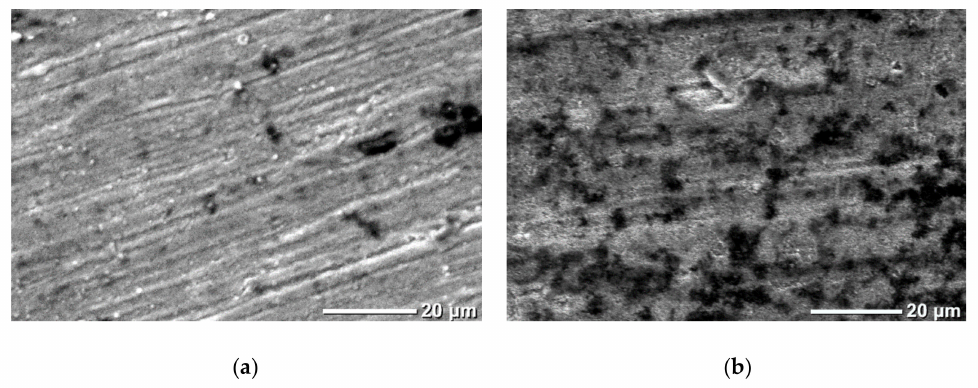
Figure 5. SEM images of the titanium surface: initial ( a ) and after plasma treatment ( b ).